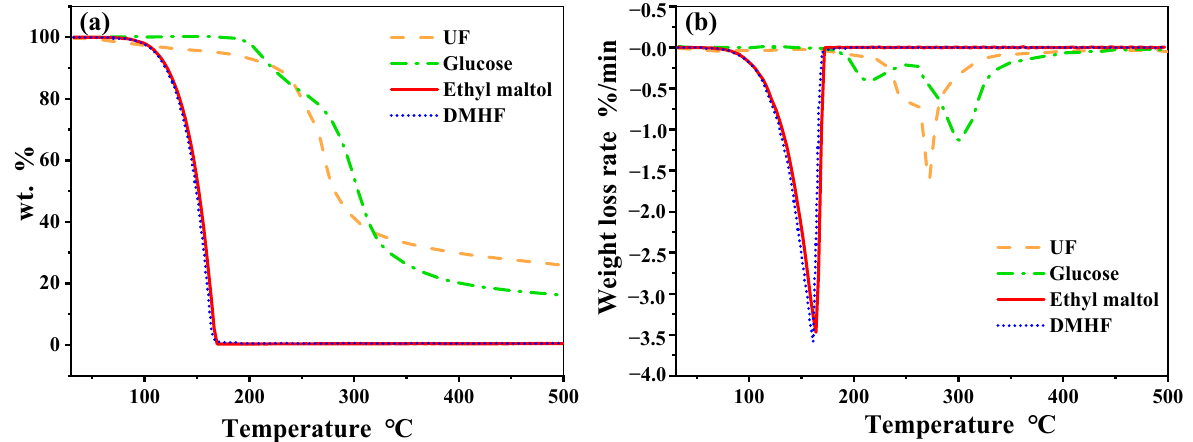
Figure 2. ( a ) TG and ( b ) DTG curves of UF, glucose, ethyl maltol, and 2,5-dimethyl-4-hydroxy-3(2H)-furanone (DMHF).